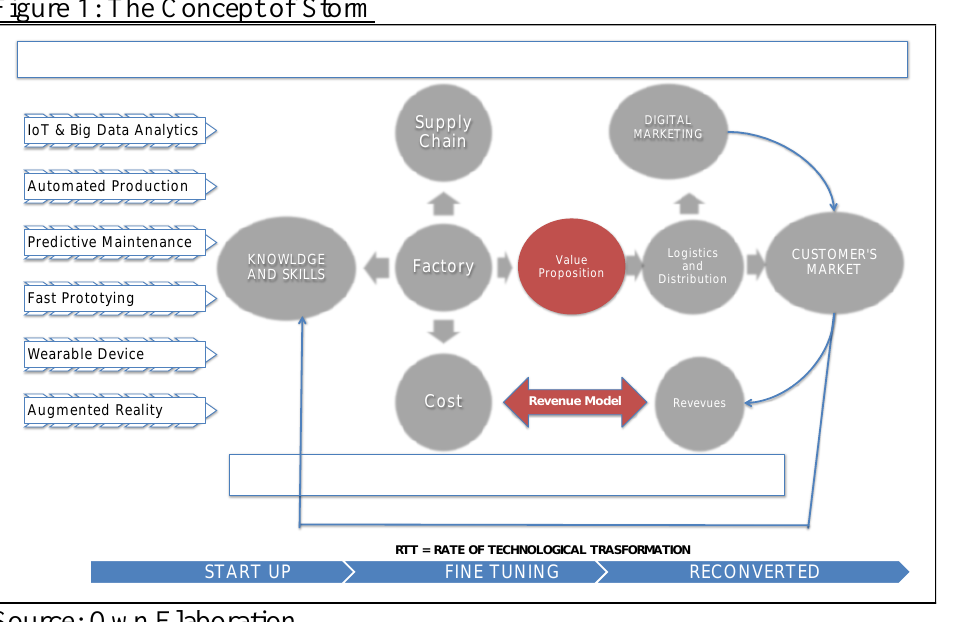
Figure 1: The Concept of Storm